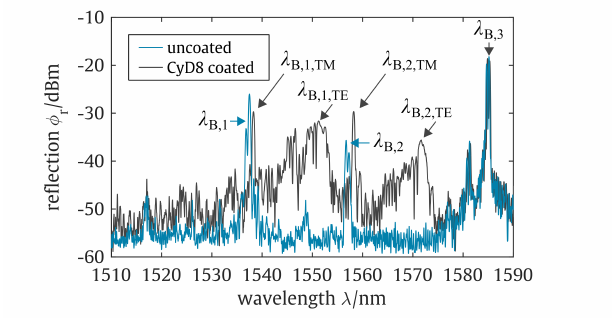
Figure 5. Reflection spectra of an uncoated planar Bragg grating sensor and the sensor coated with cyclodextrin derivative